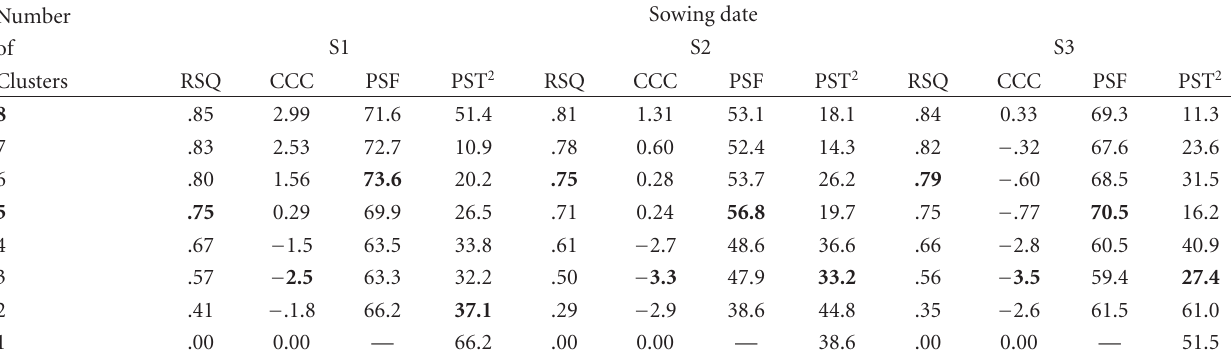
Table 6: Ward’s minimum variance cluster analysis: RSQ, CCC, PSF, and PST 2